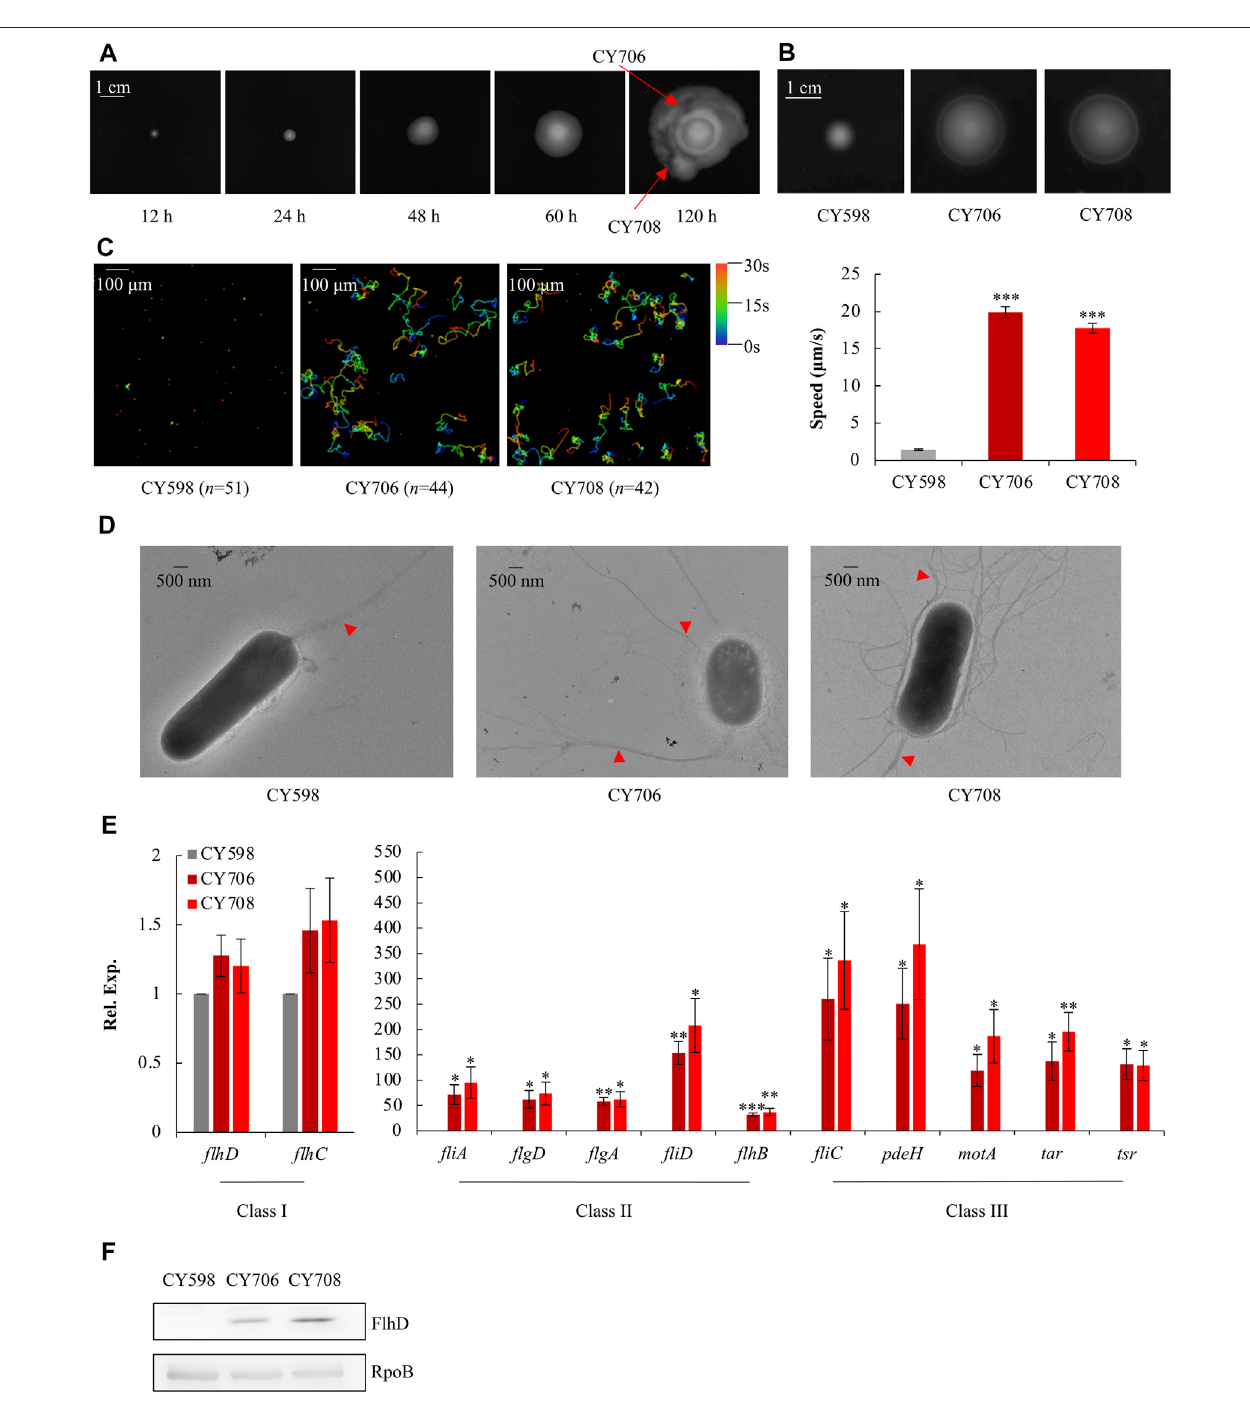
FIGURE1| Isolation and characterizationofhypermotile mutantsevolved from CY598. (A) Theswimming zones formed by CY598on the soft agarplate (0.4%) at different time points at 37 ° C. Putative hypermotile mutants were isolated from arrowed areas. (B) Swimming motility of the three strains on soft agar plates (0.25%) after 6-h incubation at 37 ° C. Three independent cultures were tested, and one representative image is shown. (C) Swimming speed of the three strains in liquid culture. The left plots showed the trajectories of the single-cell movement of the three strains. The rainbow colors correspond to the tracking time, and “ n ” represents the numberofthecellstrackedintheimage.Theswimmingspeedwasexpressedastheaverage ± S.E.M.intherightplots,calculatedfrom128to141individualtrajectories combinedfromthreeindependentexperiments.*** p ≤ 0.001 versus theswimmingspeedofthewild-typestrain,CY598. (D) Flagellaproductionofsinglecellsofthethree strains.Onerepresentativeimageofatleastthreeindependentculturesisshown.Redarrowsmarkrepresentative fl agella. (E) Theexpressionofexamplegenesselected from ClassI, ClassII,and ClassIII fl agellagenesinthethreestrainsdetected byqRT-PCR.ThemRNAlevelofeach geneinCY598wasnormalized to1,and thatCY706 and CY708 were determined relative to this value. The relative expression was shown as the average ± S.E.M. of three independent experiments. * p ≤ 0.05, ** p ≤ 0.01, *** p ≤ 0.001 versus the relative expression by the wild-type strain, CY598. (F) The protein levels of FlhD in the three strains. RpoB was used as a loading control. Three independent western blots were tested, and one representative result is